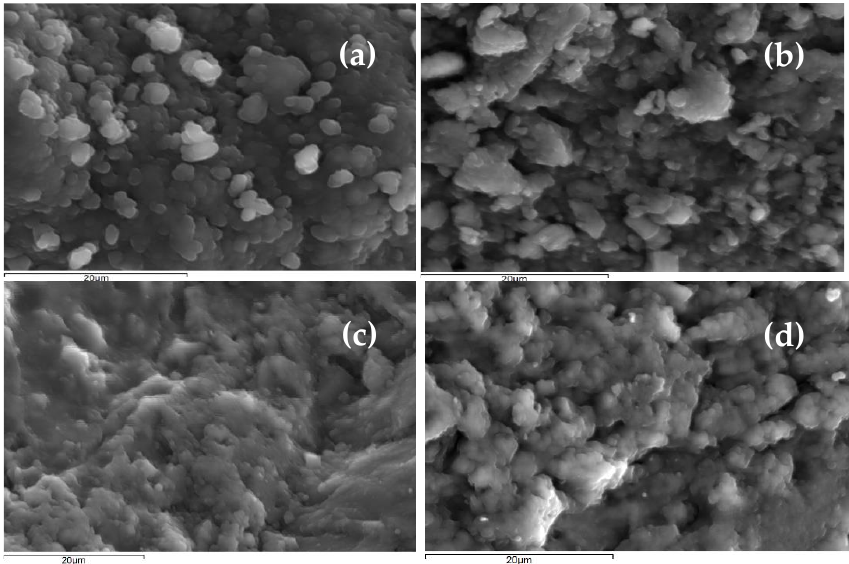
Figure 1. SEM images taken at a magnification of 2500× of ( a ) 0 – 1 mm NZ, ( b ) 0 – 1 mm Ag-MNZ, ( c ) 1 – 3 mm NZ, and ( d ) 1 – 3 mm Ag-MNZ.